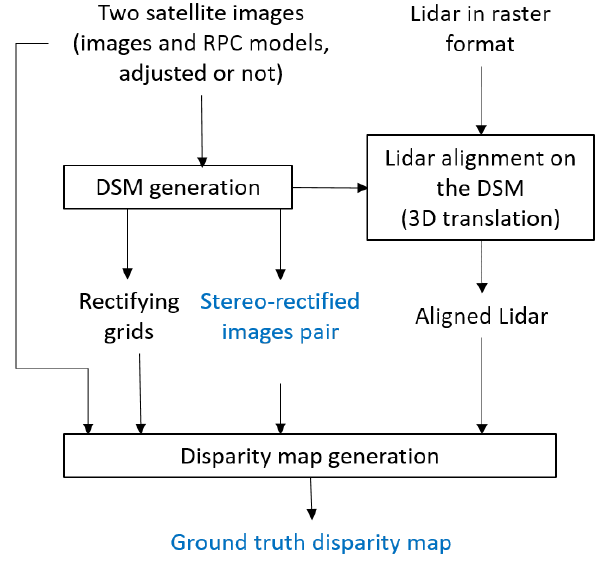
Figure 1. Ground truth pipeline overview on small areas of interest (where bundle adjustment can be safely bypassed). The inputs are a satellite imagery pair and lidar. The outputs are stereo-rectified images pair and a ground truth disparity